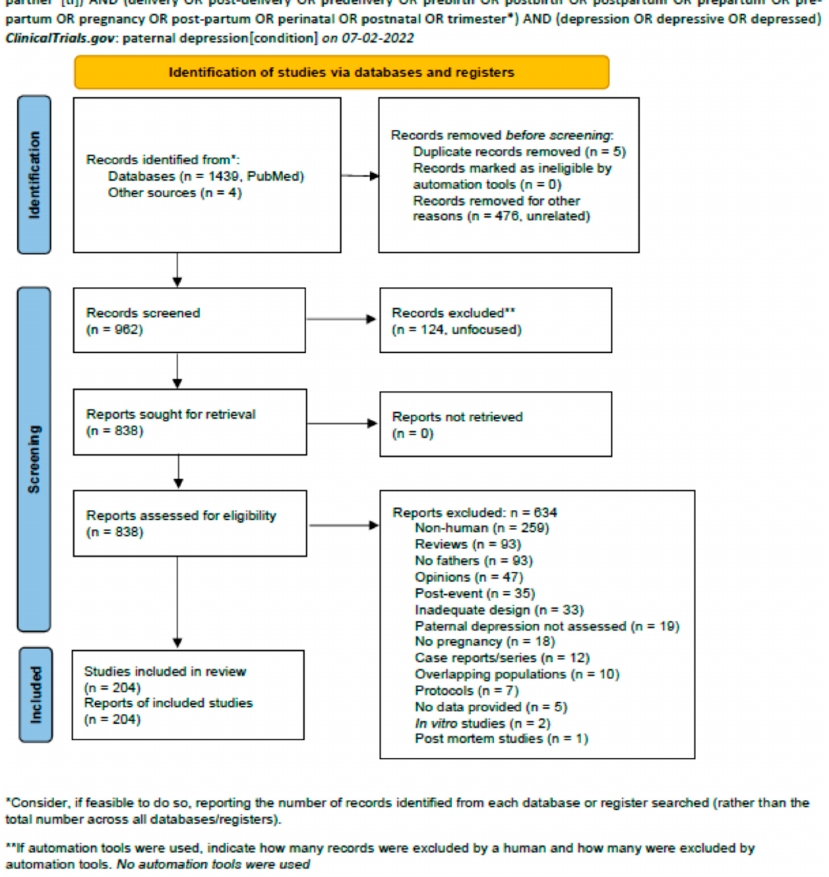
Figure 1. PRISMA flow diagram of the search strategy, showing the selection process with reasons for exclusion [11].